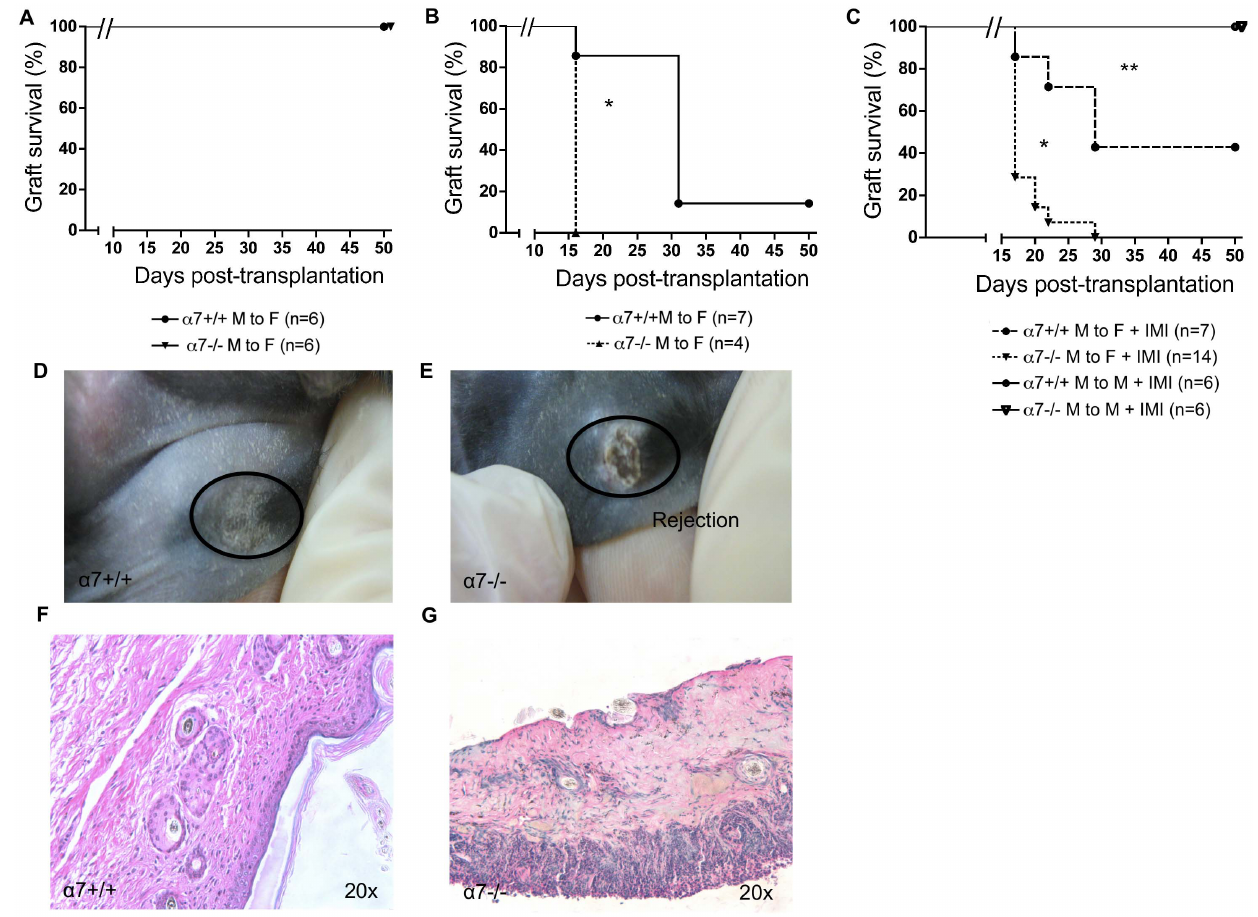
Figure 1. The cholinergic pathway modulates minor mismatched skin allograft rejection in the context of TLR stimulation. ( A to C ): Male to female (minor-mismatched) skin allografts were performed in either a 7nAchR-sufficient ( a 7 + / + ) or a 7nAchR-deficient ( a 7 2 / 2 ) donor- recipient combinations. a 7 + / + or a 7 2 / 2 recipients are coming from the same heterozygous breeders ( a 7 + / 2 ) and genotyped (as described in Material and methods). Skin graft survival was compared in a specific pathogen free animal facility (SPF) ( A ) or in a conventional animal facility ( B ). In other experiments, male to male (matched) or male to female skin grafts were performed in the SPF animal facility. At day 10, 250 mg of imiquimod (a TLR7-agonist) was applied topically on the graft and 5 days later bandages were removed. Skin graft survival in either a 7 + / + or a 7 2 / 2 donor- recipient combinations is shown ( C ). Two independent experiments showed similar results, (*): p , 0.05 compared to a 7 + / + male to female; (**): p , 0.05 compared to matched. ( D,E ): Macroscopic images of male skin grafts in female recipients 17 days after transplantation. A representative wild type ( a 7 + / + ) accepted (healthy) skin graft is shown in D . A rejected male skin graft in the a 7 2 / 2 donor-recipient combination is shown in E . ( F,G ): Histology of imiquimod-induced minor mismatch skin graft rejection. The histology (20 6 magnification) of either accepted male skin in the a 7 + / + donor-recipient combination ( F ) or a 7 2 / 2 donor-recipient combination ( G ) is shown. Skin grafts were harvested 17 days after transplantation followed by PAS-D